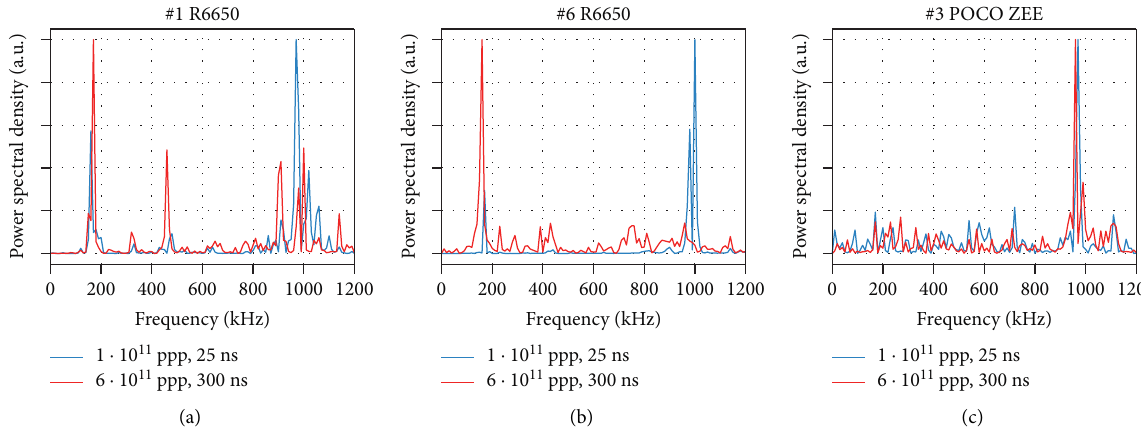
Figure 12: Frequency analysis of the radial surface velocity presented in Figure 8. The normalized power density within the first 100 μ s after beam impact is shown for beam impacts with intensities of 1 and 6 × 10 11 ppp of samples #1 SGL R6650 (a), #6 SGL R6650 (b), and #3 POCO ZEE